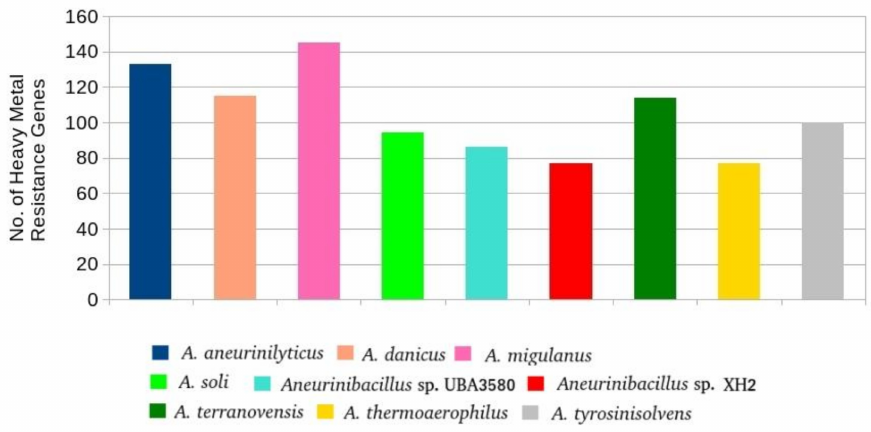
Figure 5. Distribution of heavy metal resistance genes in Aneurinibacillus